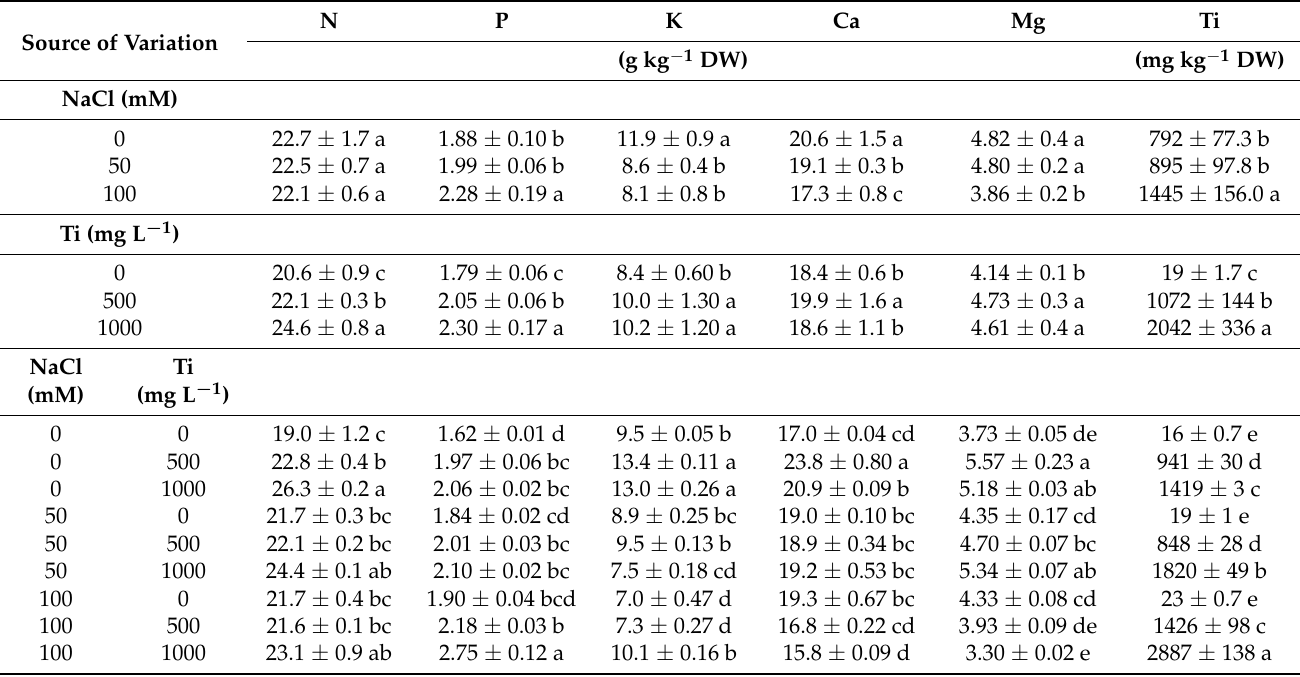
Table 7. Main and interaction effects of NaCl and TiO 2 on the concentration of N, P, K, Ca, Mg,